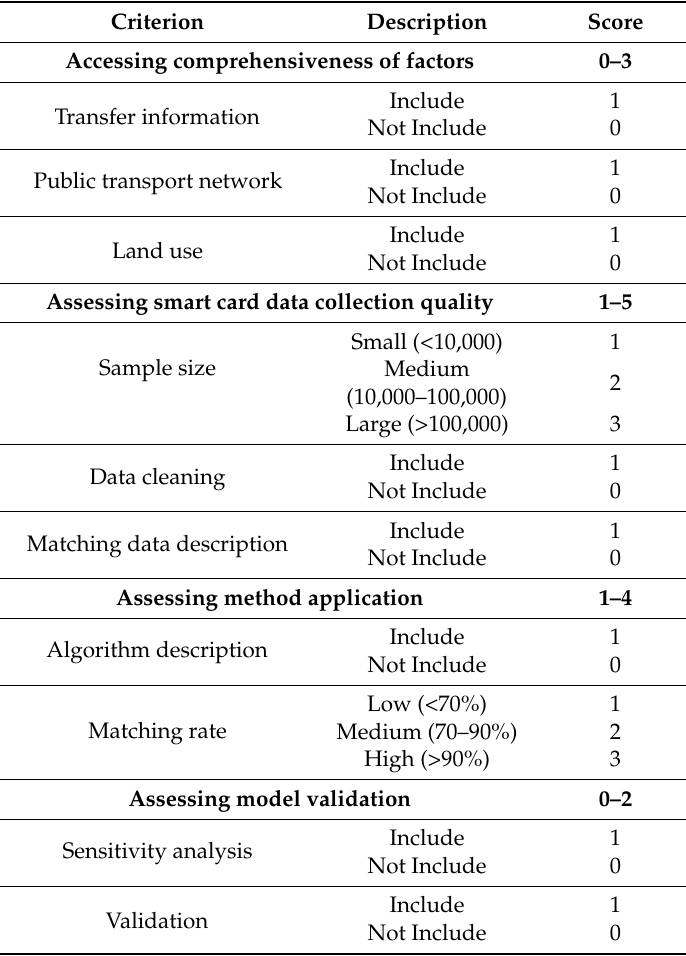
Table 1. Checklist for evaluating studies’